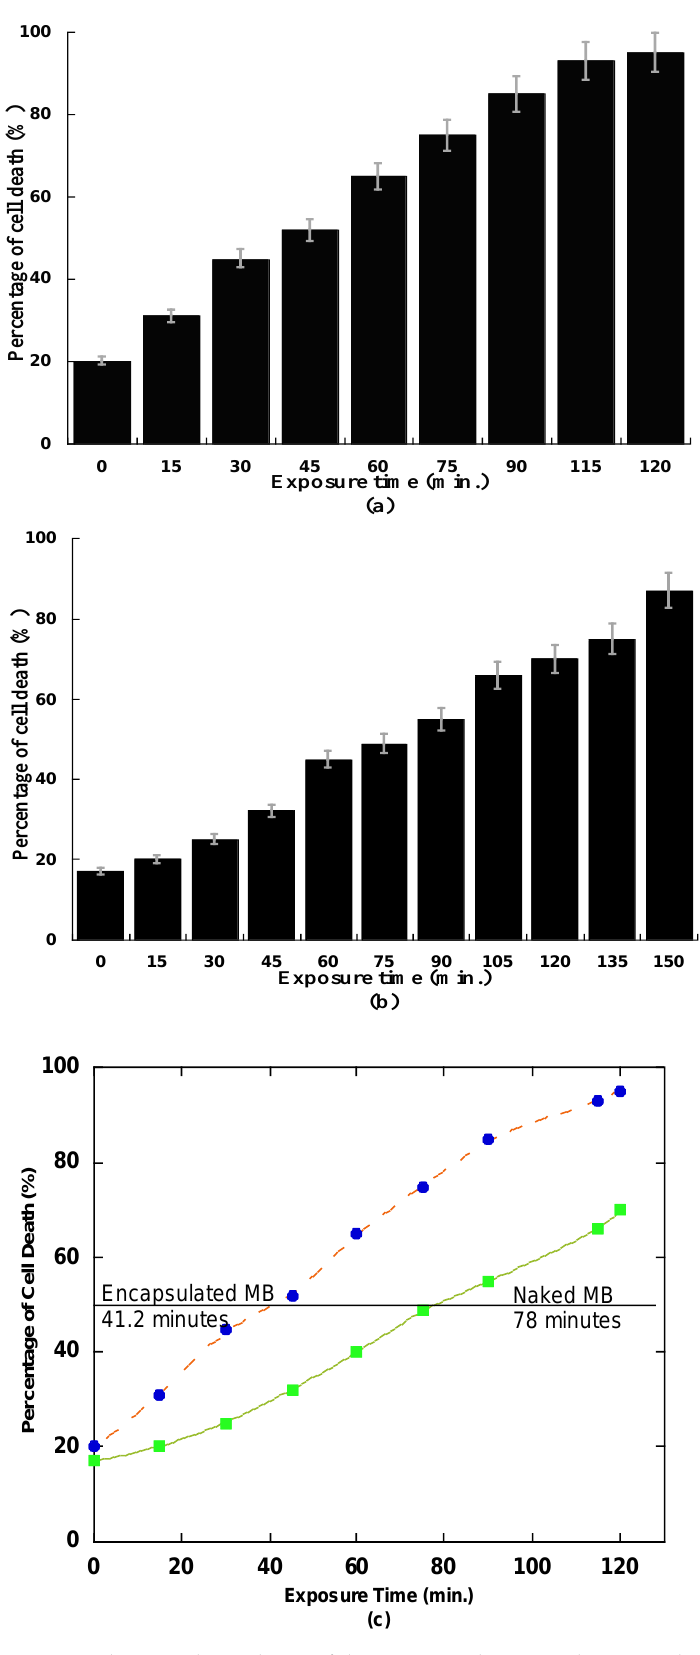
Figure 7. The time dependence of the treatment by using the optimal concentration for ( a ) encapsu- lated MB and ( b ) naked MB. ( c ) The optimum exposure time for the treatment. As a treatment, the photodynamic effect required a lower concentration of encapsu- lated MB than naked MB to achieve the same level of toxicity on osteosarcoma cells. On the other hand, the photodynamic effect of naked MB required a longer exposure time to kill half of the target cells using the optimal MB concentration compared to encapsulated MB. Irradiation with light resulted in effective damage to the cancer cells due to the in- creased absorption of light and singlet oxygen production in ROS by encapsulated MB molecules, which are collected together by the encapsulation in SiNPs, compared to naked MB, which is dispersed in solution. As a result, its interaction with light and its effects were weaker and dispersed [24,35]. As a treatment, to achieve the same level of toxicity on osteosarcoma cells, the pho- todynamic effect of MB encapsulated required a lower concentration of MB than bare MB. On the other hand, the photodynamic effect of bare MB required a longer exposure time to kill half of the target cells using the optimal MB concentration compared to encapsu- lated MB. Irradiation with light resulted in effective damage to the cancer cells due to increased absorption of light and singlet oxygen production in ROS, as a result of